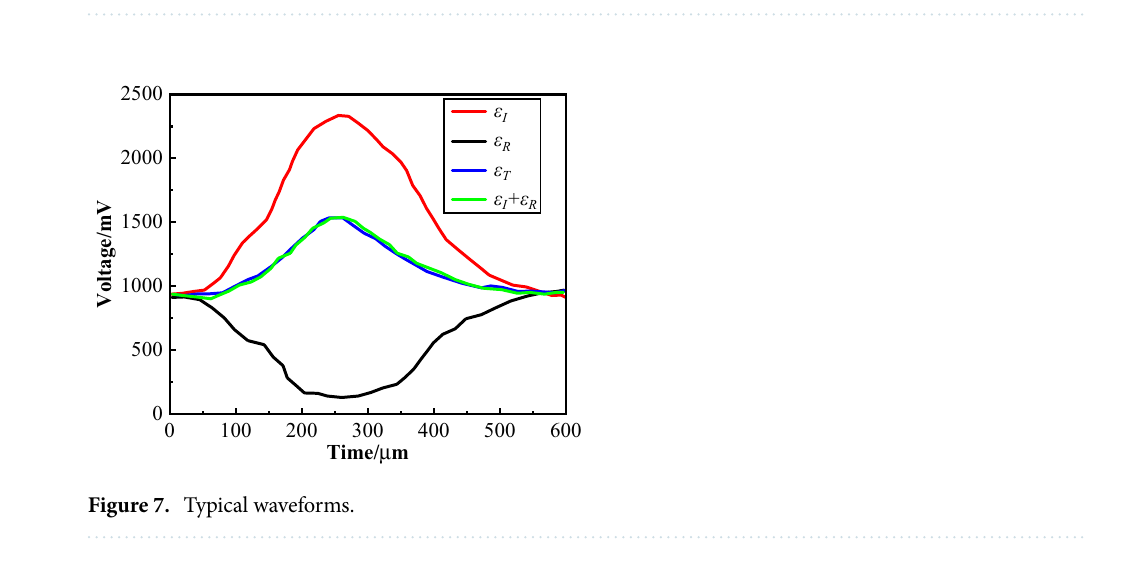
Figure 6. Schematic diagram of stress wave propagation in dynamic mechanical test.